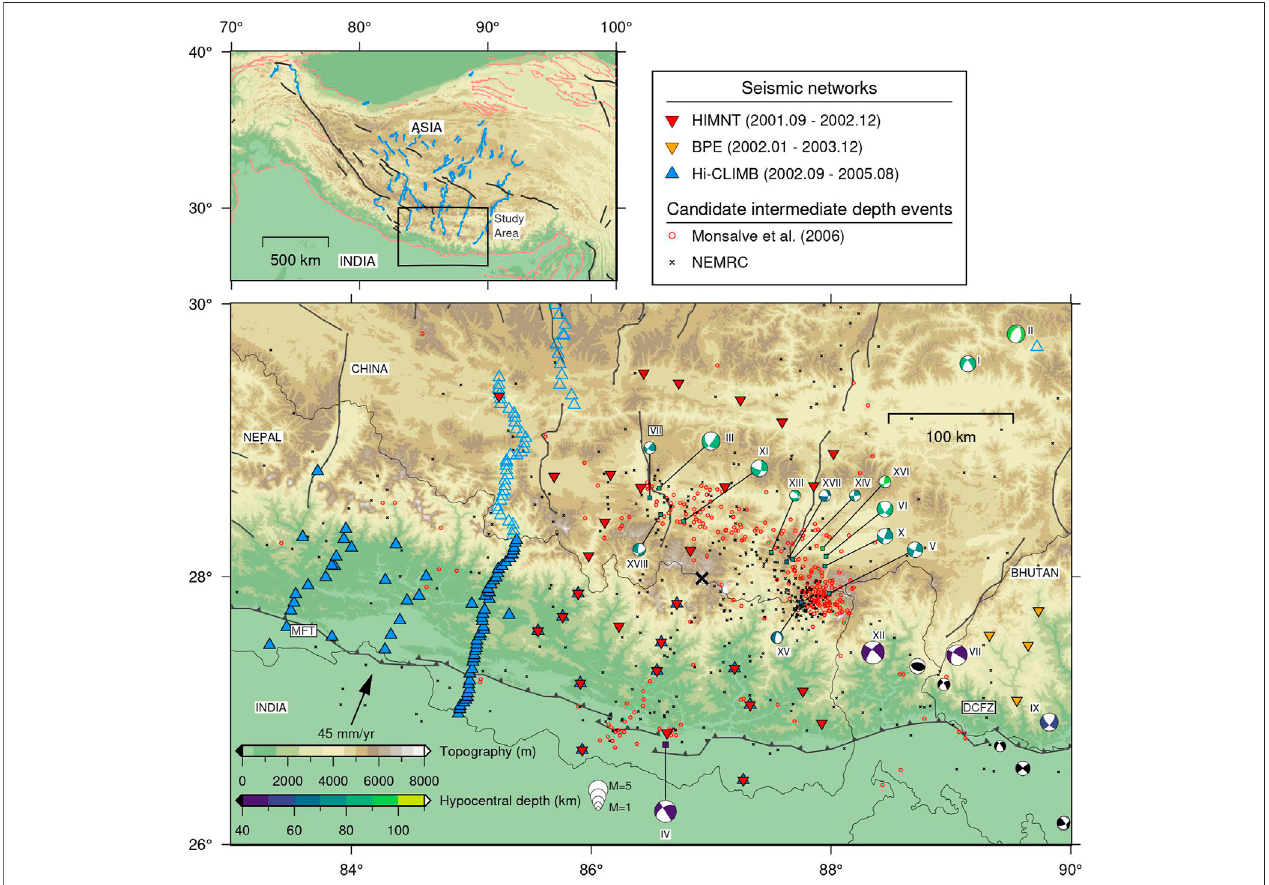
FIGURE 1 | Spatial distribution of seismic networks operating in the Himalayas between late 2001 and mid-2003. Red and orange inverted triangles show the HIMNTandBPEseismicsites,respectively.BluetrianglesdepictHi-CLIMB.EmptybluetrianglesshowthelocationsoftheHi-CLIMBseismicsitesnotusedinthisstudy. Red circlesand blackcrossesindicatetheepicenters ofthecandidateintermediate-depth events(Details canbe foundin Table1 ).Blackcross highlightsthelocationof Mt Everest. Active faults are shown as thick gray lines. The black arrow indicates the local velocity of Indian Plate relative to Eurasia ( ∼ 45 mm/yr; DeMets et al., 2010). MFT is the Main Frontal Thrust and DCFZ is the Dhubri-Chungthang fault zone. Focal mechanisms colored according to their hypocentral depths and noted with RomannumeralsfromItoXVIII(seemoredetailsin SupplementaryTableS1 ofthesupplementarymaterial)depictmomenttensorinversionsdeterminedbytheGlobal CMT catalog and previous studies for intermediate-depth events in the region (Chen et al., 1981; Molnar and Chen, 1983; Chen, 1988; Chen and Kao, 1996; Zhu and Helmberger,1996;delaTorreetal.,2007;AlvizuriandHetényi,2019).Blackfocalmechanismsshowshallowerthan40 kmdepthearthquakesdeterminedbyDiehletal. (2017) that lie along the Dhubri-Chungthang fault zone (DCFZ). Inset shows the location of the study area in the broader region. Active faults (Styron et al., 2010) are colored according to the type of faulting (red for thrust, blue for normal, and black for strike-slip faults).